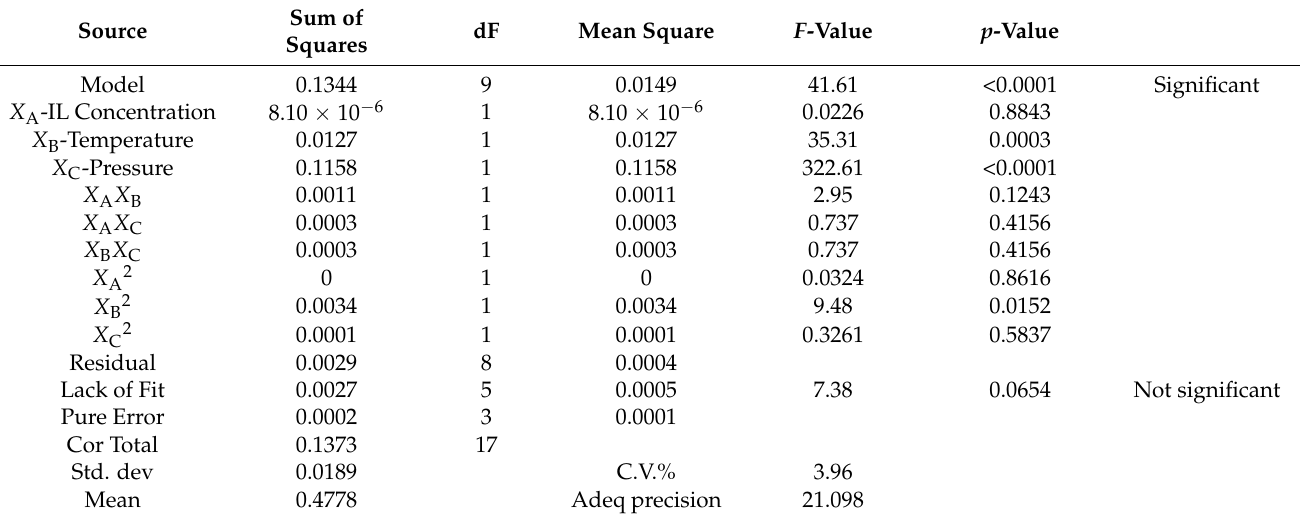
Table 6. ANOVA for quadratic modeling of CO 2 absorption.